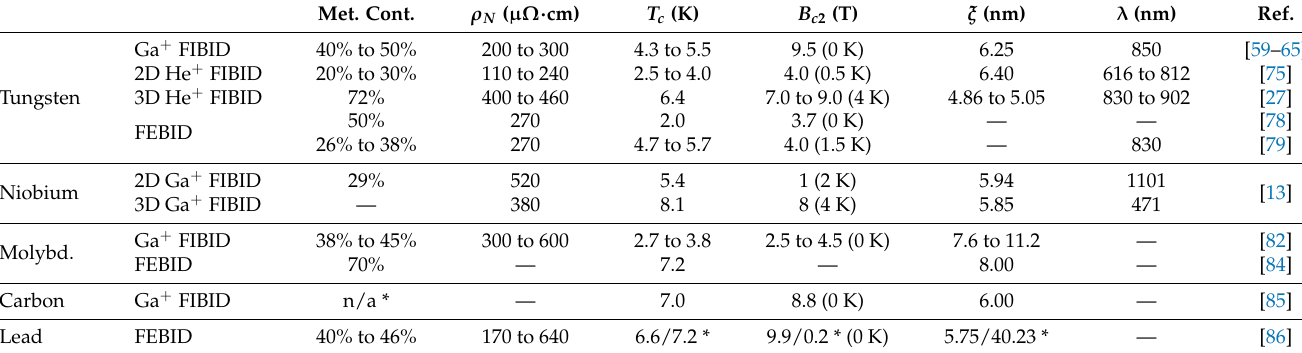
Table 1. Reported features and characteristic parameters of superconducting materials prepared by FIBID and FEBID. The values of reported critical field are indicated along with the temperature at which they were estimated. In the case of lead, parameters corresponding to the two different superconducting phases detected by the authors are separated by a slash. (*: see text for clarification). Met.